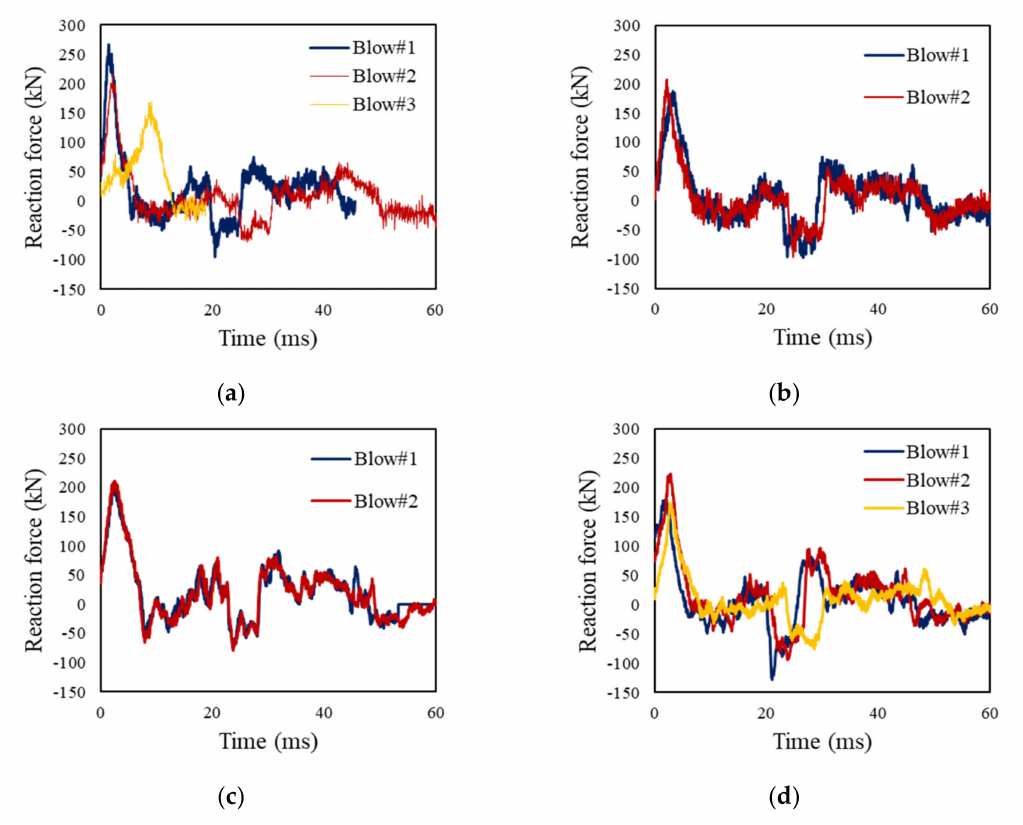
Figure 4. Time history of reaction force at each blow: ( a ) NSC-NF; ( b ) NSC-F-S; ( c ) NC-F-S; ( d )